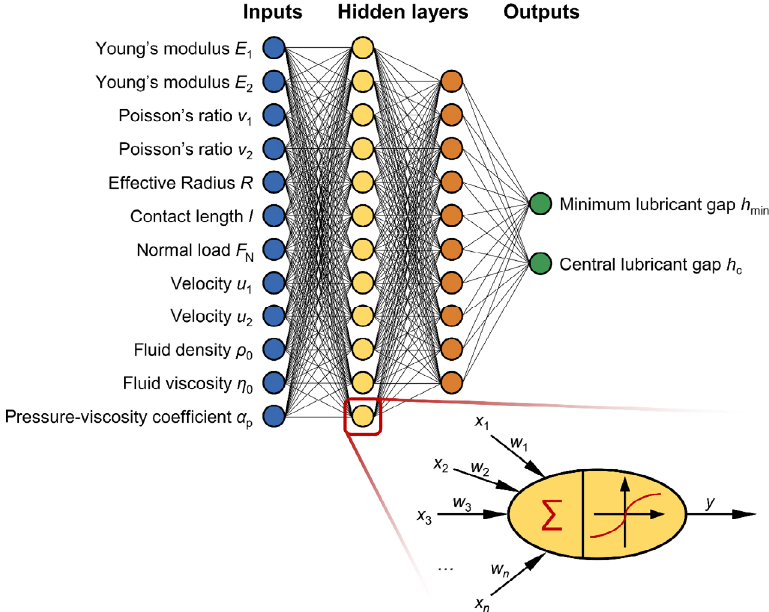
Fig. 2 Schematic of the correlation between EHL contact parameters and film thickness parameters using